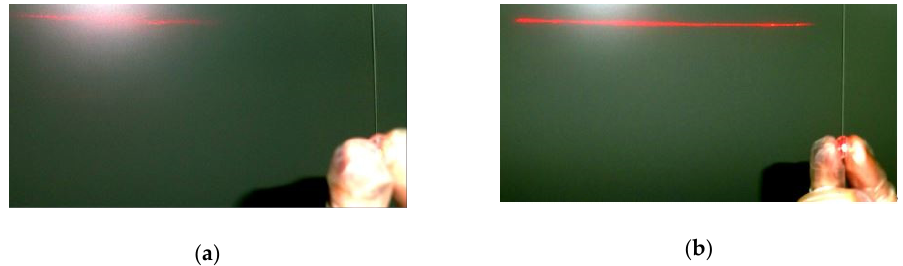
Figure 17. Transcription effects of pressing dies after PGM according to a laser being emitted on the lens: ( a ) MLA made using a pressing die with a surface roughness of 0.08 µm Ra; ( b ) MLA made using the pressing die with a surface roughness of 0.023 µm Ra.